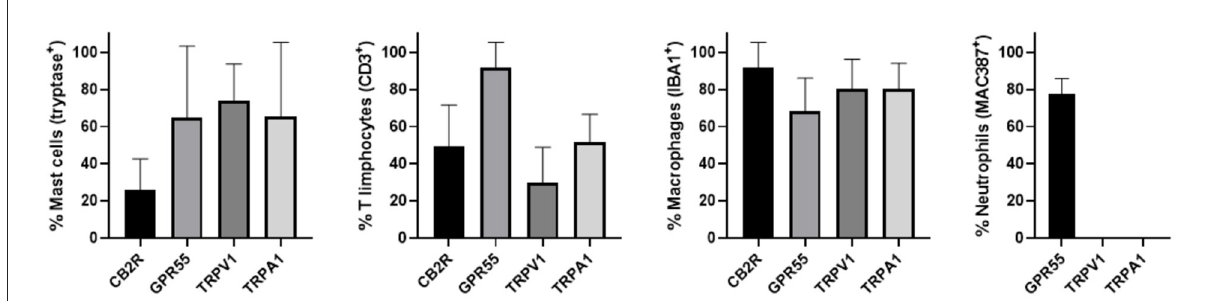
FIGURE8 Percentage of mast cells, T limphocytes, macrophages/dendritic cells and neutrophils that expressed CB2R, GPR55, TRPV1 and TRPA1. Mast cells expressing tryptase were immunoreactive for CB2R, GPR55, TRPV1, and TRPA1. T limphocytes expressing CD3 were immunoreactive for CB2R, GPR55, TRPV1, and TRPA1. Macrophages/dendritic cells expressing IBA1 were immunoreactive for CB2R, GPR55, TRPV1, and TRPA1. Neutrophils expressing MAC387 were immunoreactive only for GPR55. Data are presented as Mean ( ±